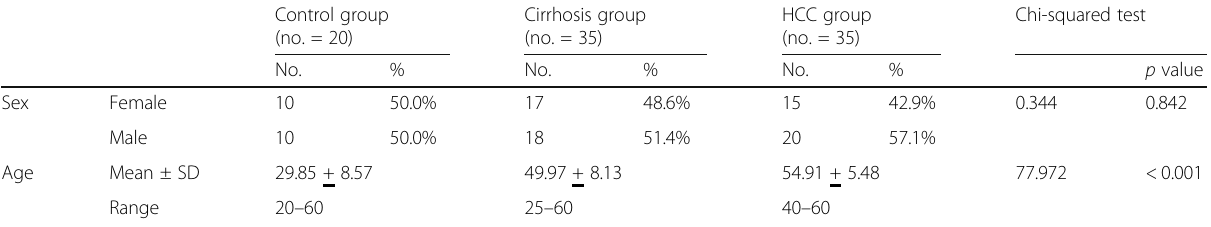
Table 1 Demographic data of all studied groups